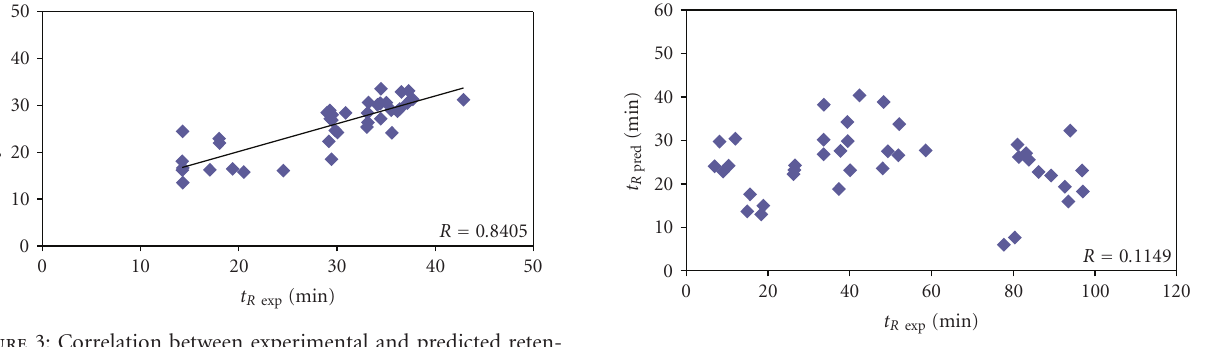
Figure 4: Correlation between experimental and predicted reten- tion times for a set of test peptides obtained from Bacillus subtilis proteome. The proteins were identified on the basis of one peptide with X corr below 1.5 ( n =